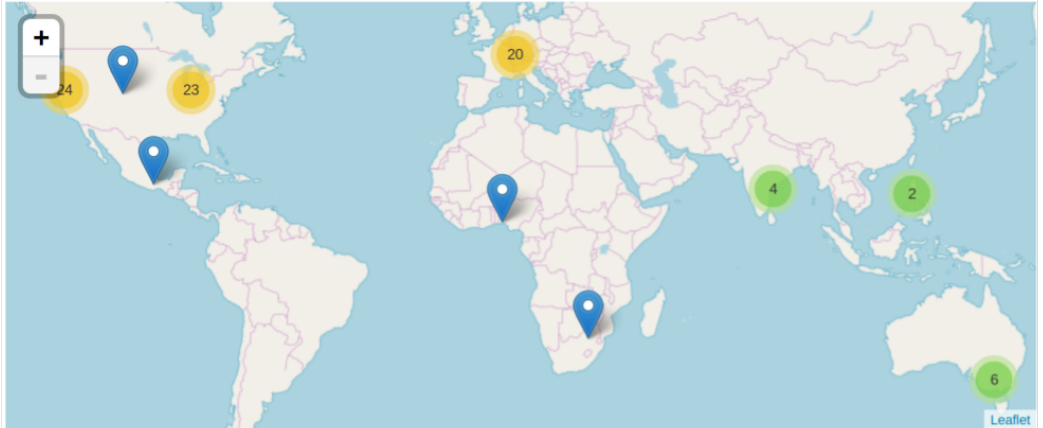
Figure 4. Geographical plot of all the geo-located tweets of the Twitter data, indicating very few tweets have location